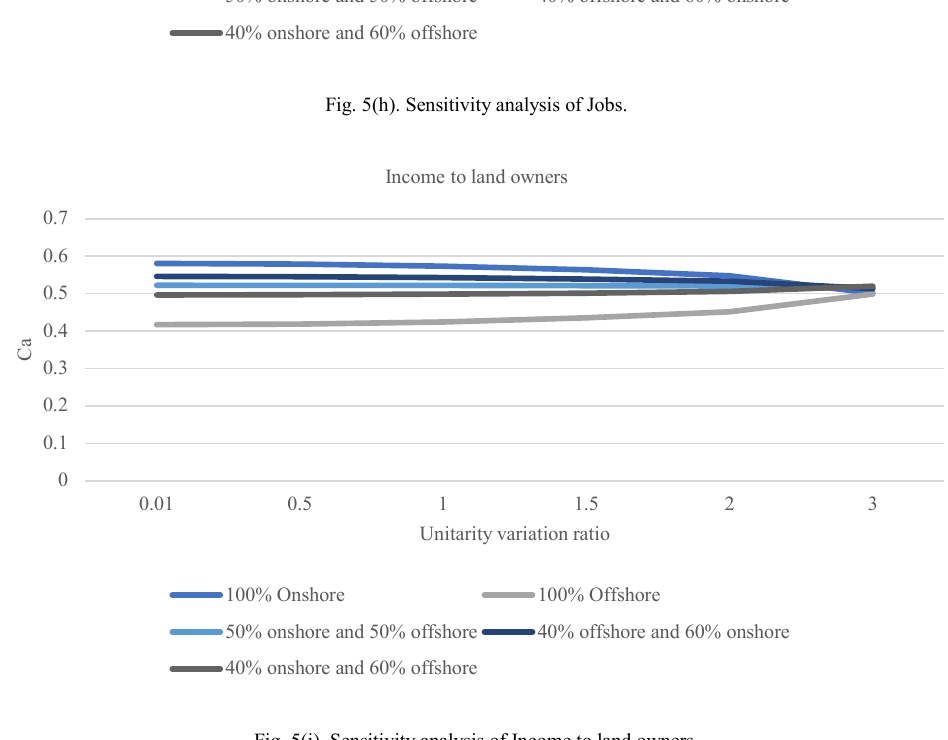
Fig. 5(i). Sensitivity analysis of Income to land